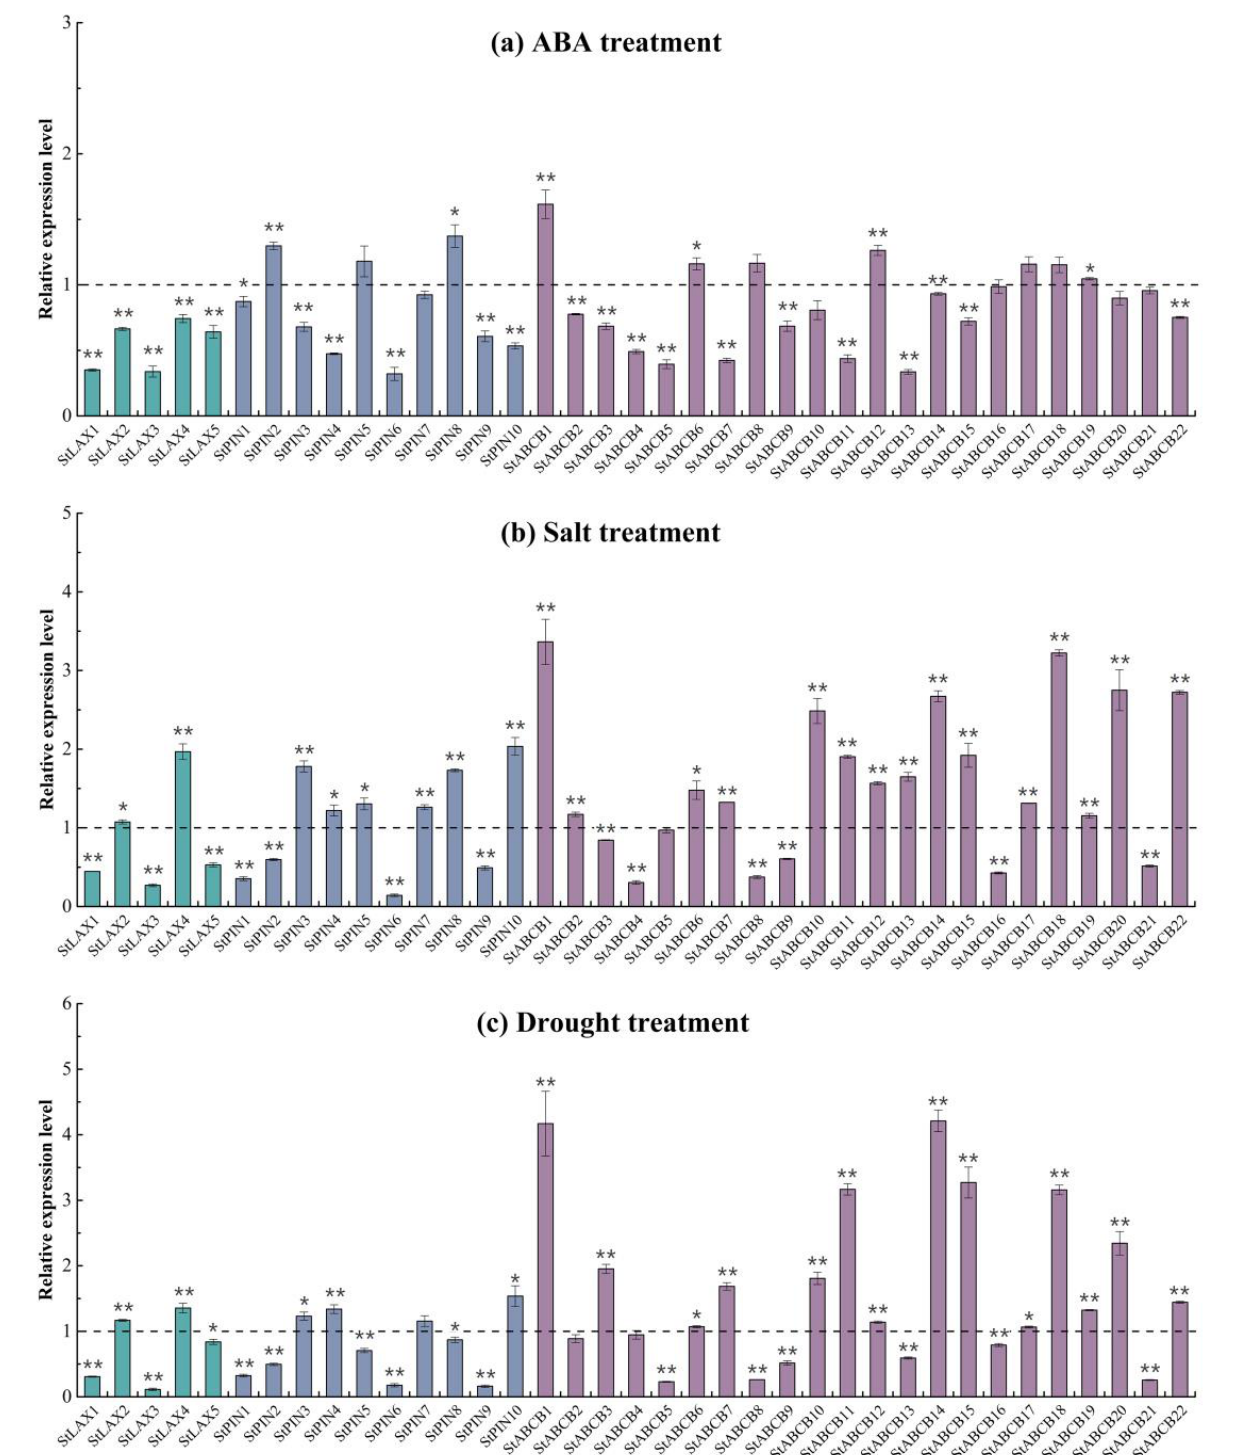
Figure 8. Expression levels of StLAX, StPIN, and StABCB family genes in response to abscisic acid (ABA) and abiotic stress. Total RNA was extracted from four−week−old potato plantlets treated with 100 μM ABA ( a ) for 3 h, 200 mM NaCl ( b ) or 20% ( w / v ) polyethylene glycol (PEG) (drought) ( c ) for 24 h. The relative mRNA level of each gene was normalized with respect to the internal reference gene (ef1−a). The data were analyzed by three biological repeats, and SDs are shown with error bars. (* t −test p −value < 0.05, ** t −test p −value < 0.01.)